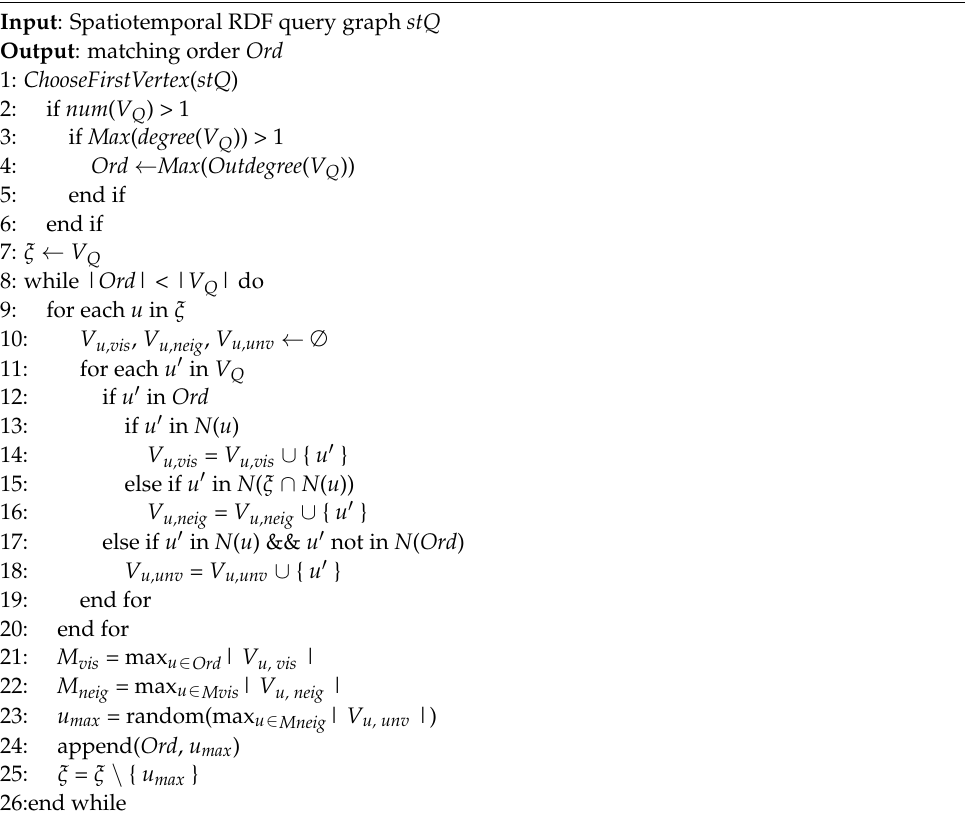
Algorithm 1: Calculating the Matching Order Algorithm